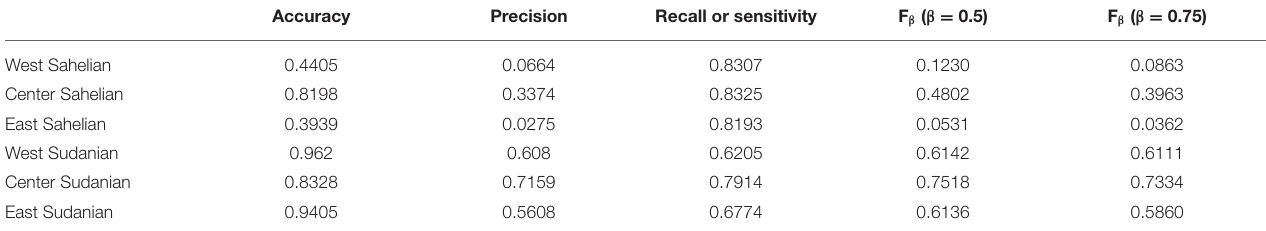
TABLE 5 | Calculated classification performance